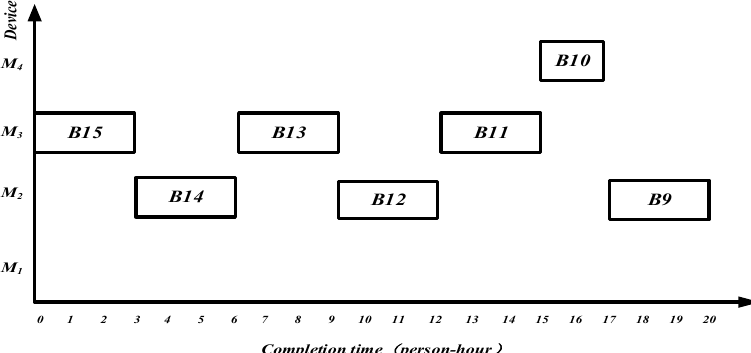
Figure 11. Gantt chart of operation string T B2 allocated to workshop f 1 with 20 person-hours.